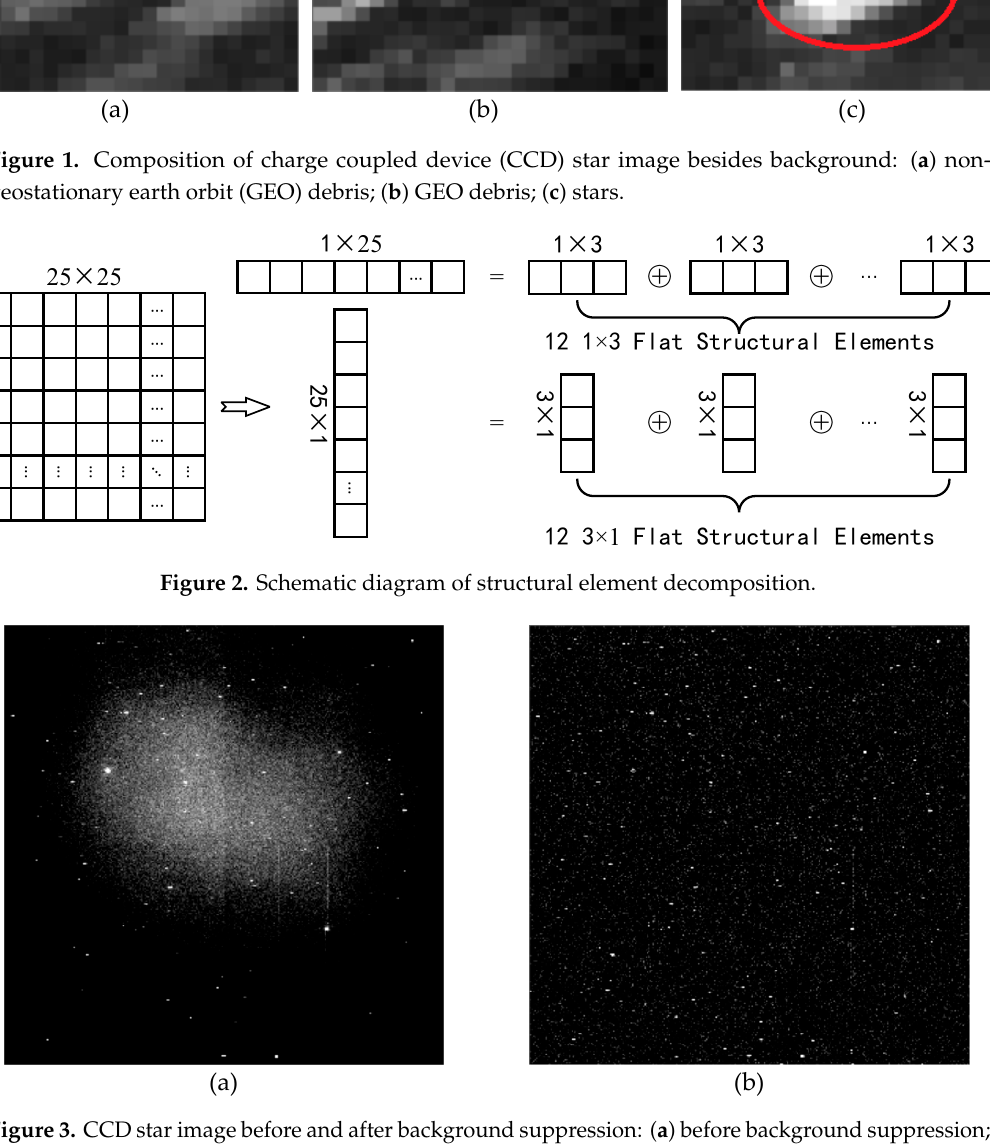
Figure 3. CCD star image before and after background suppression: ( a ) before background suppression; ( b ) after background suppression.